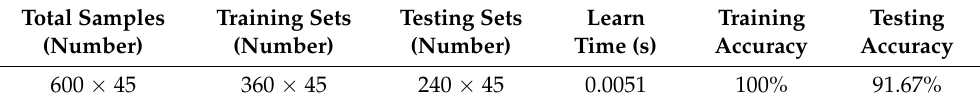
Table 5. The data used for the KELM.